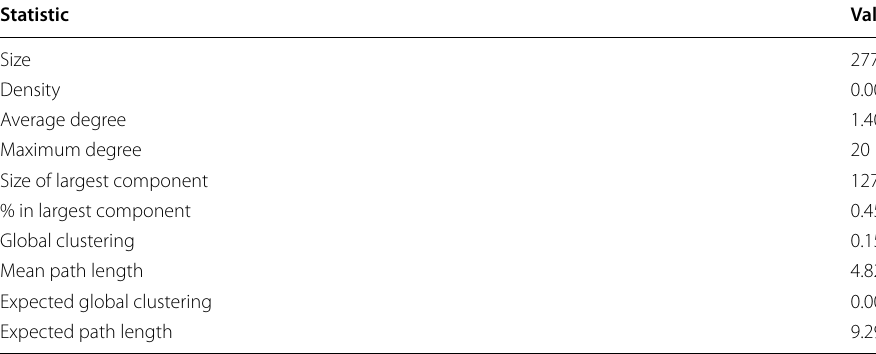
Table 2 Think tank interlock network